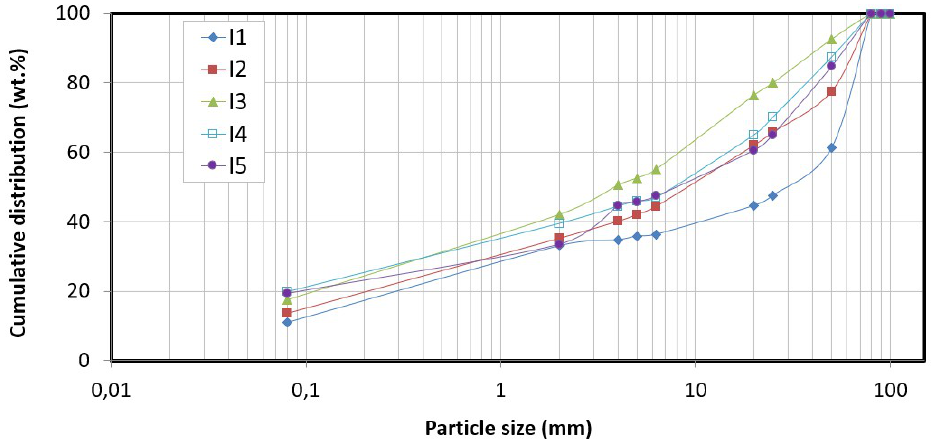
Minerals 2019 , 9 , x FOR PEER REVIEW Figure 5. Particle size distribution of the five collected materials. Figure 5. Particle size distribution of the five collected materials.